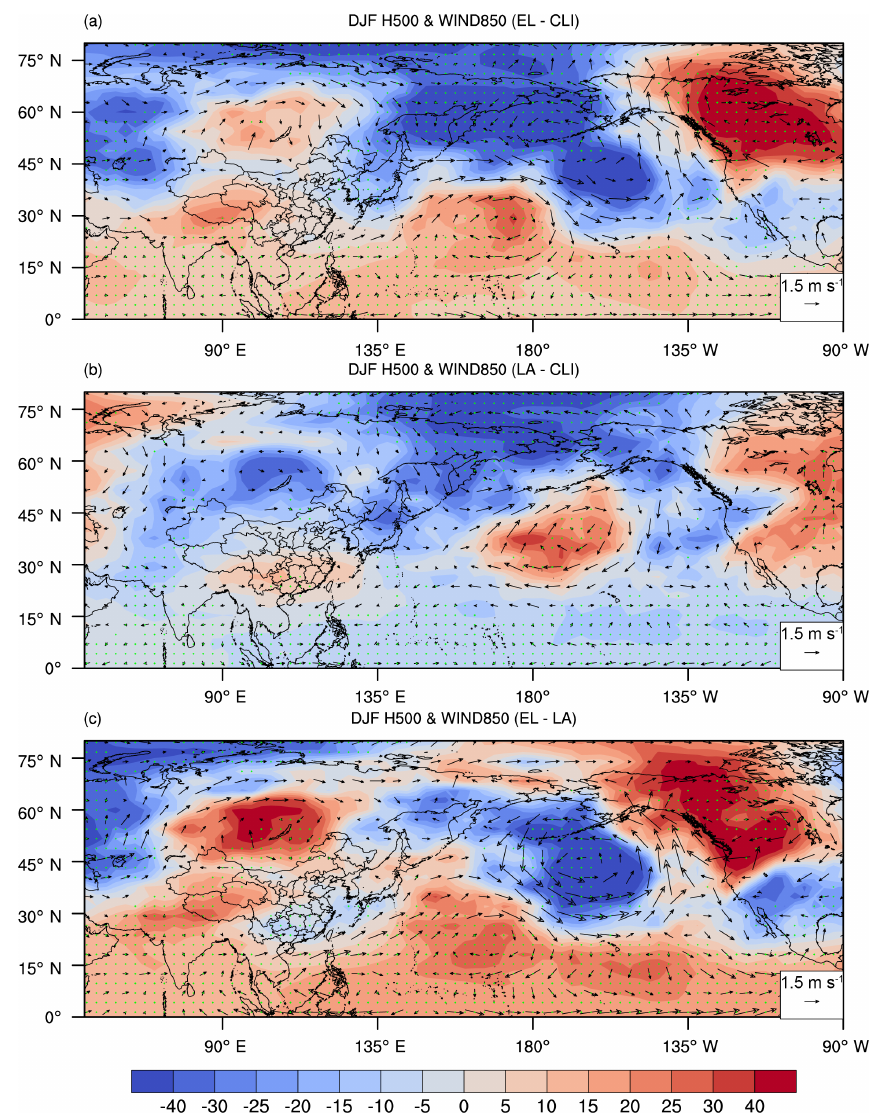
Figure 7. Medians of the simulated differences in winter-average geopotential height at 500hPa (H500, shaded; units: gpm) and wind at 850hPa (WIND850, vector; units: ms − 1 ) between (a) EL and CLI, (b) LA and CLI, and (c) EL and LA, with green dots indicating that the differences of H500 between more than 70% of ensemble member pairs have the same sign as the median